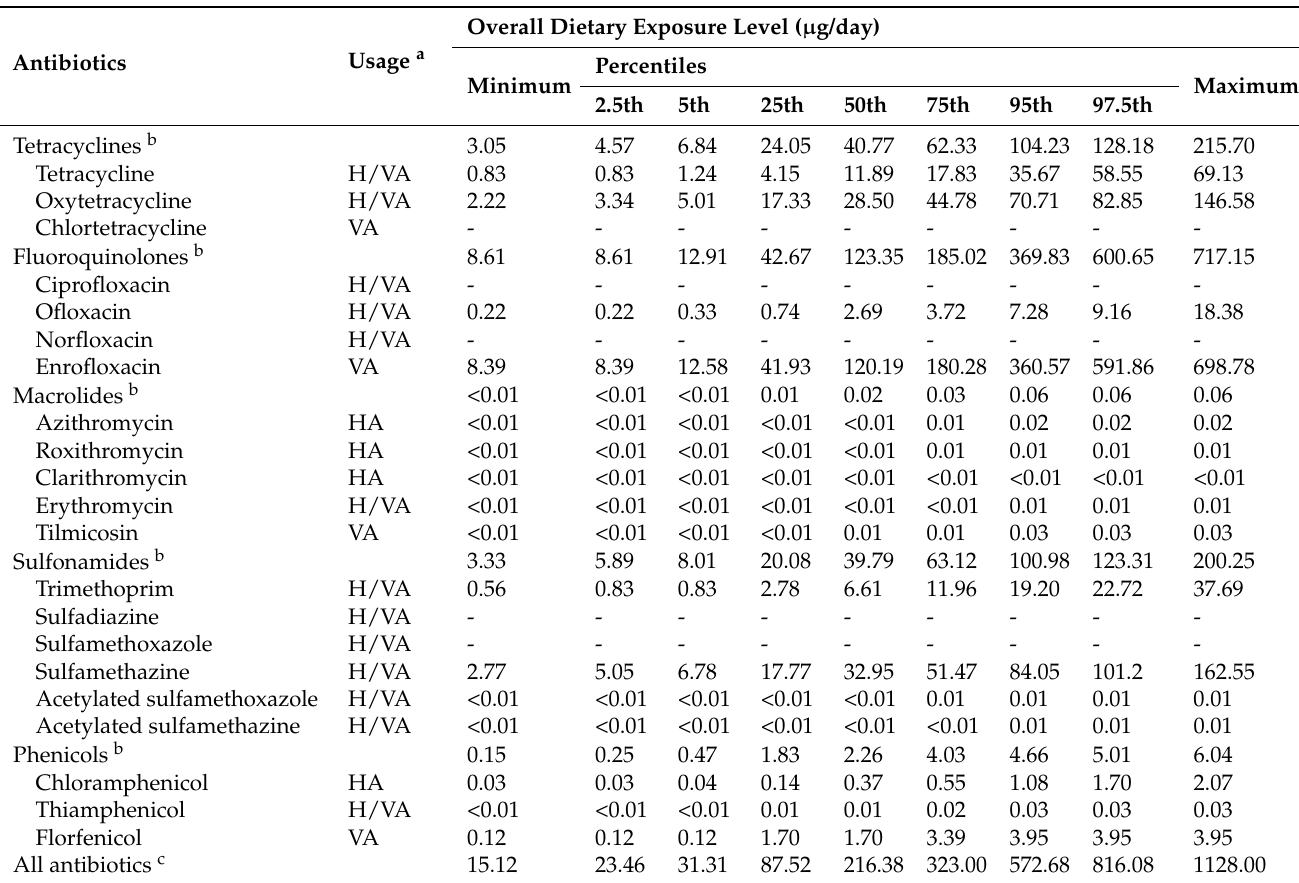
Table 1. Overall dietary exposure level to antibiotics among